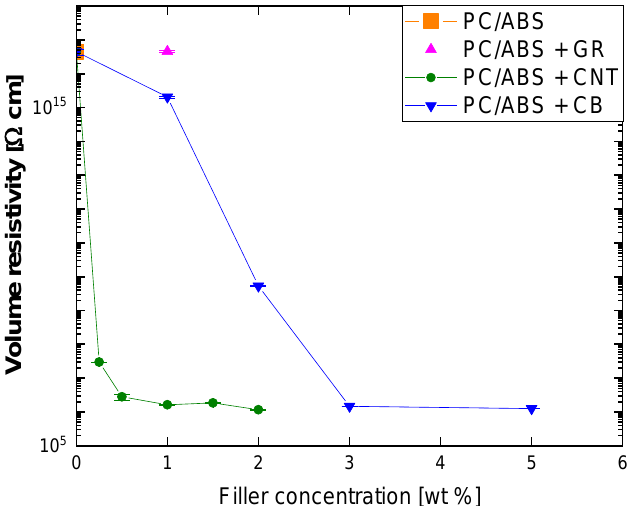
Figure 1. Variation in electrical resistivity with fillers’ concentration in polycarbonate/acrylonitrile butadiene styrene (PC/ABS) composites prepared by melt mixing.